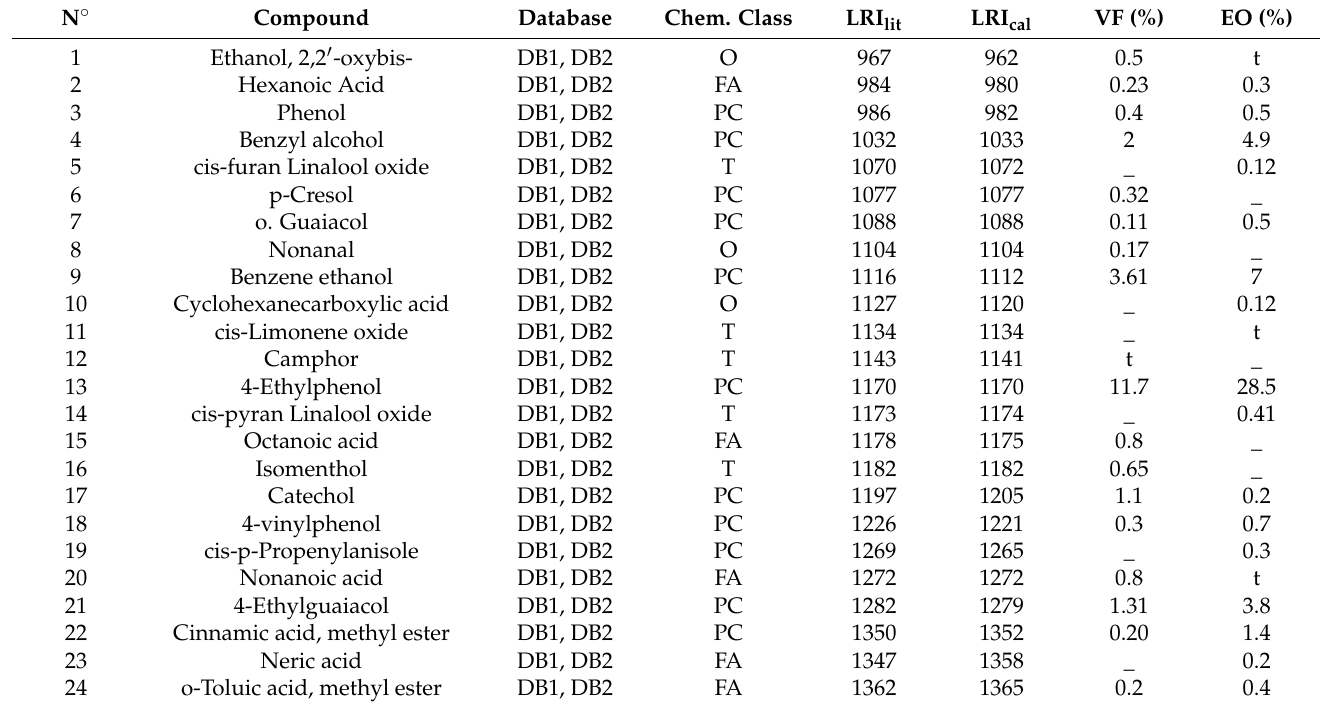
Table 1. Chemical composition of VF and